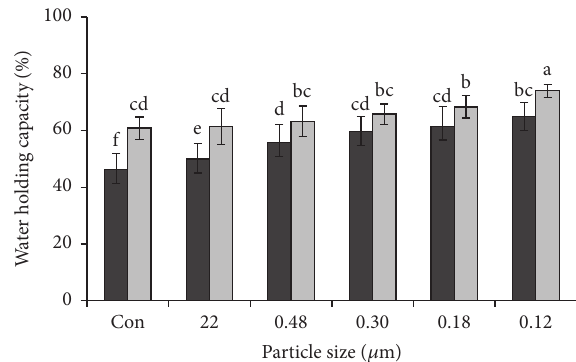
Figure 6: Water holding capacity of the surimi gels with different size of fish bone particles and thermal treatments. Black bars: gel cooked at 90 ∘ C for 30min. Grey bars: gel incubated at 40 ∘ C for 1h followed by 90 ∘ C cooking for 30 min. Different lowercases indicate significant differences among different treatments ( 𝑃 < 0.05